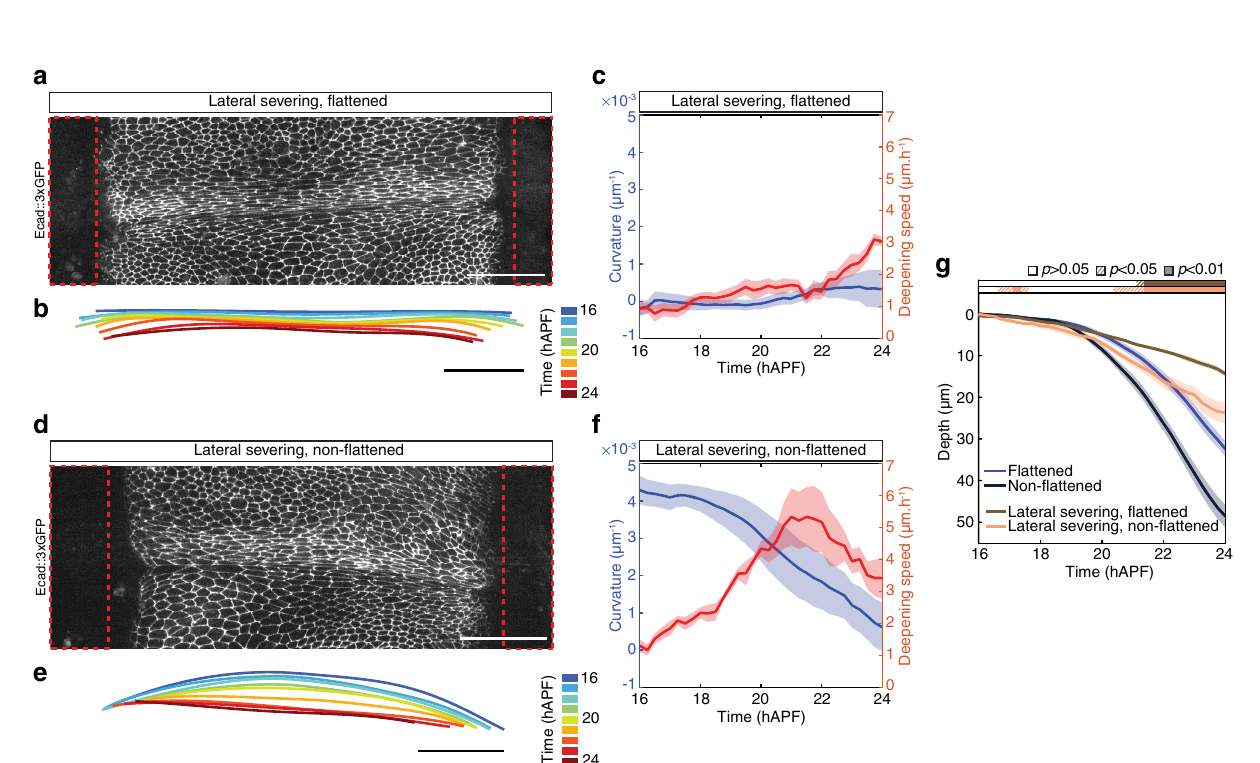
Fig. 6 | Local curvature along the neck fold controls folding dynamics. a Transverse view time-lapse images of the neck region labeled by Ecad::3×GPF at 18, 21, and 24 hAPF in a non- fl attened pupa (i.e., imaged without coverslip fl atten- ing). Blue line, the position of the apical fold front. Dashed line, midline position. See also Supplementary Movie 4. b Successive positions of the apical fold front, color-coded according to time, in a pupa imaged without coverslip fl attening ( a ). Dashed line, midline position. c Graph of apical fold front deepening speed (mean±sem) in pupae imaged without coverslip fl attening (non- fl attened, N =11 pupae) and with coverslip fl attening ( fl attened, N =101 pupae) as a function of developmental time. Horizontal box: p -values of Welch tests performed between non- fl attened and fl attened experimental conditions at successive time points (white p >0.05,striped p <0.05,solid p <0.01). d Graphofcurvature(mean±sem) in pupae imaged without coverslip fl attening (non- fl attened, N =110 pupae) and with coverslip fl attening ( fl attened, N =10 pupae) as a function of developmental time.Horizontalbox: p -valuesofWelchtestsperformedbetweennon- fl attenedand fl attenedexperimentalconditionsatsuccessivetimepoints(white p >0.05,striped p <0.05, solid p <0.01). e Graph of the apical fold front deepening speed (mean±sem) and of the product of curvature and ML apical initial recoil velocity upon laser ablation in the neck region (mean±sem) in pupae imaged without coverslip fl attening for a given Position ML at a given color-coded developmental time. Datasets from Fig. 6c, d and Supplementary Fig. 11a were used (see corre- sponding fi gure legends for sample size). A line passing through the origin was fi tted ( R 2 =0.81). f Transverse view time-lapse images ofthe neckregion labeled by